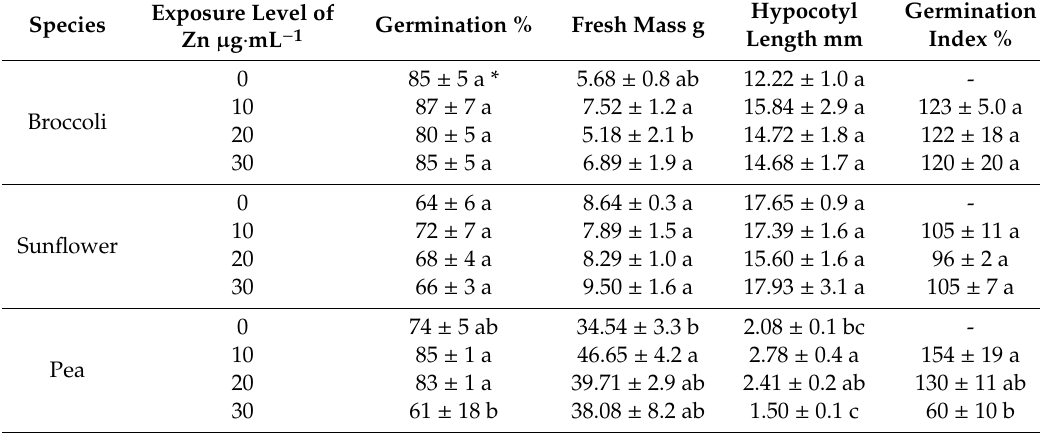
Table 1. Growth parameters of sprouts obtained after treatment with di ff erent doses of Zn. The measurements were performed after 4 days (broccoli) and 5 days (pea, sunflower) of germination. Means ± SD from n = 3 (one replication consisted of 80 seeds for peas and sunflowers, and 300 seeds for broccoli).